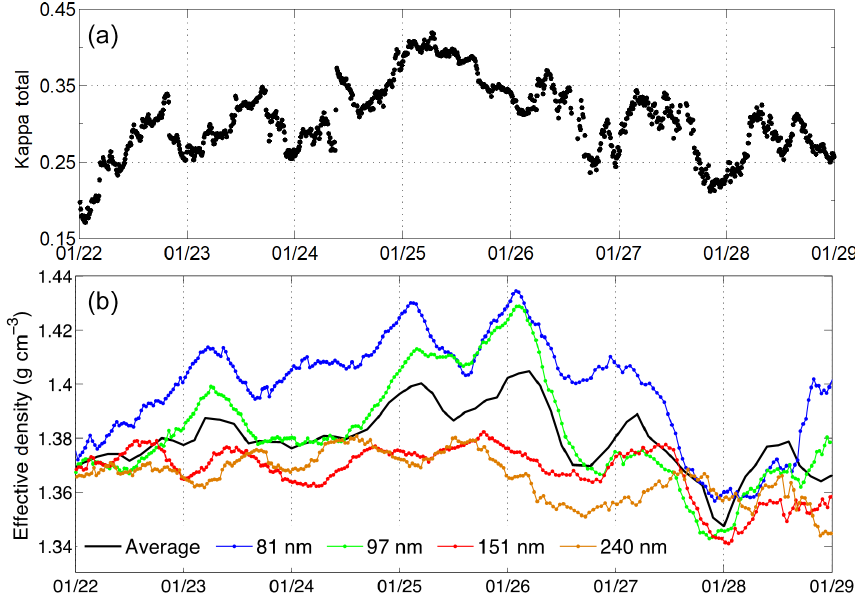
Figure 3. (a) The determined hygroscopicity based on chemical composition (i.e., kappa) of the aerosols. (b) Temporal evolutions of the effective density of particles with a diameter of 81 (blue), 97 (green), 151 (red) and 240nm (orange) and the weighted average of the four particle sizes (black) between 21 and 29 January 2015. Dates in this figure are given in the month/day